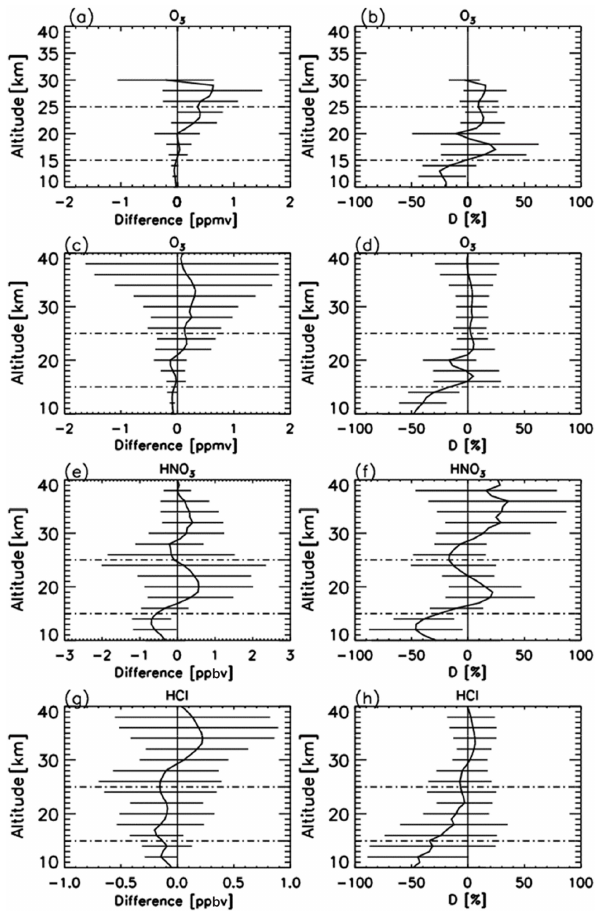
Figure 2. (a) Mean absolute and (b) mean relative differences of O 3 profiles retrieved from FTIR measurements minus those from ozonesonde measurements. (c) Mean absolute and (d) mean rela- tive differences of O 3 profiles retrieved from FTIR measurements minus those from Aura MLS measurements. (e) Mean absolute and (f) mean relative differences of HNO 3 profiles retrieved from FTIR measurements minus those from Aura MLS measurements. (g) Mean absolute and (h) mean relative differences of HCl profiles retrieved from FTIR measurements minus those from Aura MLS measurements. Horizontal bars indicate the root mean squares of differences at each altitude. Horizontal dashed bars indicate the al- titude range of our focus